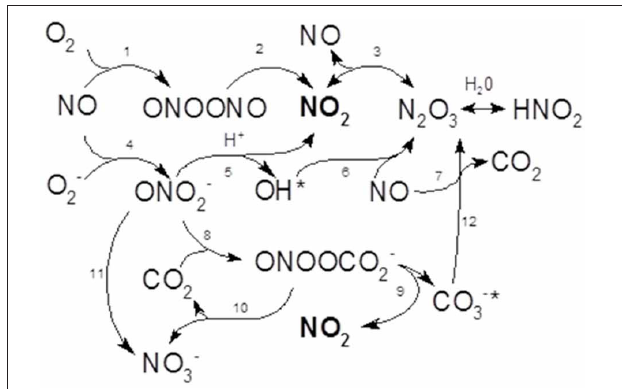
FIGURE 3 | Schematic of biologically relevant chemical reactions of NO with oxygen and superoxide radical summarizing results of Ford et al. (1993), Wink et al. (1993), Goldstein and Czapski (1995), Kharitonov et al. (1995), Goldstein et al. (1998), Espey et al. (2002a), Lancaster (2006), Lewis and Deen (1994), and Goldstein and Grabski (1995). In the presence of oxygen, NO is autooxidized to NO 2 which can further react with NO to form N 2 O 3 (Reactions 1 – 3 ). Reaction 1 is much slower in comparison with Reaction 4 which takes place in the presence of superoxide and results in the formation of peroxynitrite. The latter is unstable and decomposes with the formation of NO 2 and hydroxyl radical which is able to quickly recombine with NO. Peroxynitrite can be rapidly consumed by CO 2 to form the unstable nitrosoperoxocarbonate (ONOOCO − 2 ) (reaction 8 ) ultimately decomposing into NO 2 , nitrate and carbonate. As a result, NO 2 accumulates as a major toxic species before its conversion to stable nitrite. The nitrate and nitrite can be metabolized for respiration in hypoxic conditions or biosynthesis. The stoichoimetric coefficients are not